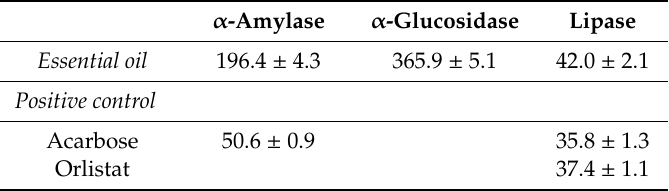
Data are expressed as means ± S.D. (n =